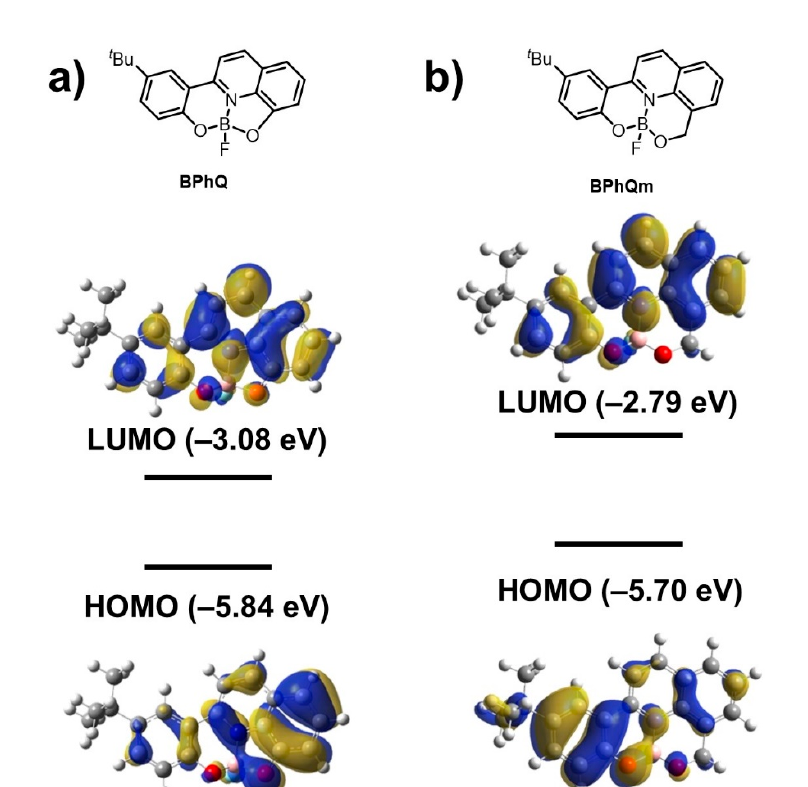
Figure 4. Structures and molecular orbital diagrams for the lowest unoccupied molecular orbital (LUMO) and highest occupied molecular orbital (HOMO) of ( a ) BPhQ ( b ) BPhQm calculated at B3LYP / 6–311 + G(d,p) with S 1 state optimized structures.